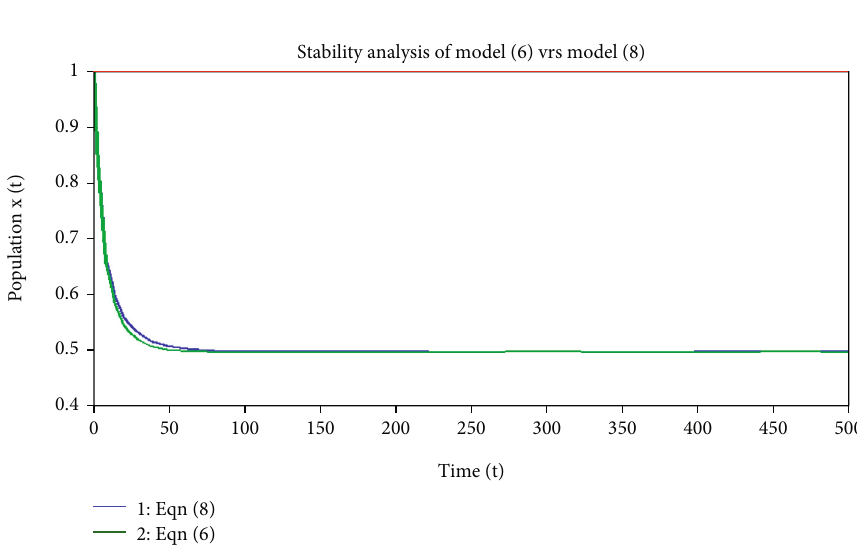
Figure 8: Stability analysis of equations (6) and (8) with r = 0 : 1 , τ = 3 : 00 , and h = 0 : 05